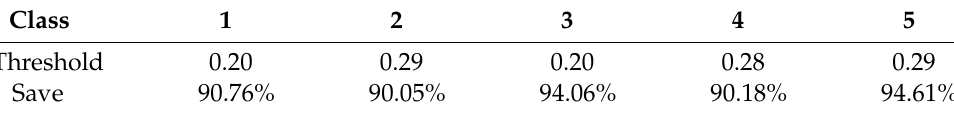
Table 1. LSH threshold and save data ratio